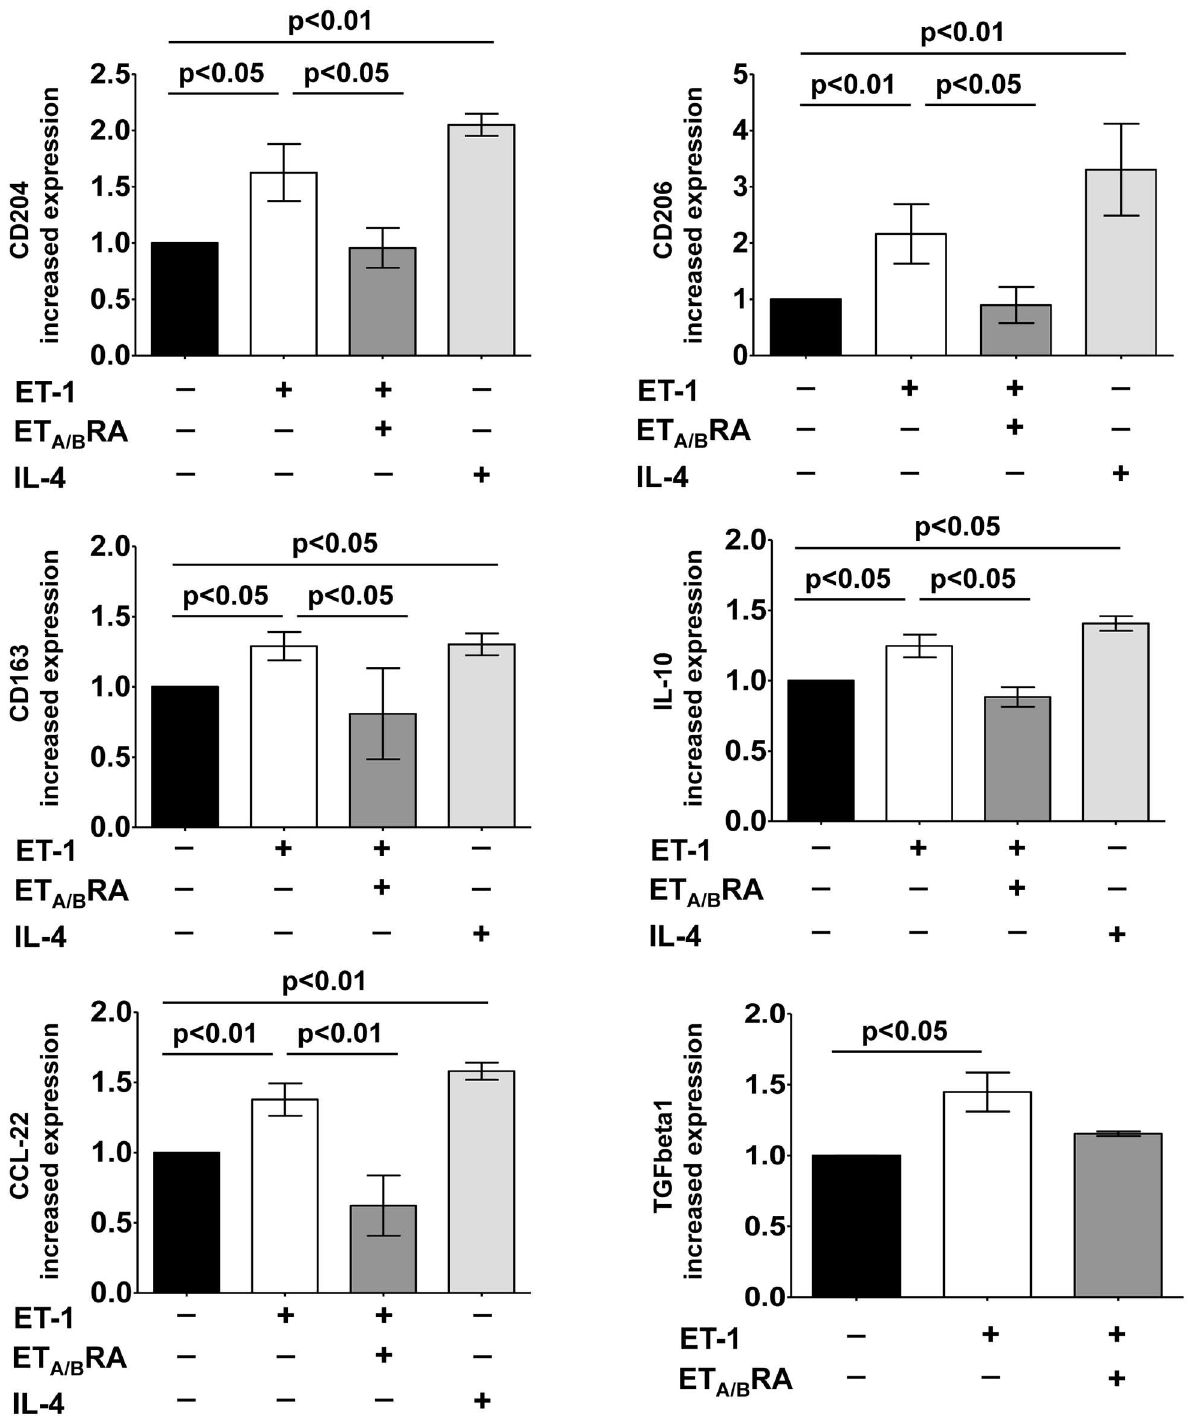
Fig 6. Evaluation of gene expression of M2 macrophage phenotype markers and TGFbeta1 in cultured human monocyte- derived macrophages. Quantitative real time polymerase chain reaction (qRT-PCR) of CD204, CD206, CD163, IL-10, CCL-22and TGFbeta1 gene expressionin cultured humanmonocyte-derived macrophages treated for 6 days with ET-1 (100nM) and IL-4 (10ng/mL) alone, or pre-treatedwith ET A/B RA (bosentan, 10 -5 M) for 1 hour before being stimulatedwith ET-1. Cultured humanmonocyte-derived macrophages maintained for 6 days in RPMI at 10% of FBS were used as untreatedcells. The qRT-PCR was performed on six independent in vitro experiments and the data of CD204, CD206, CD163, IL-10, CCL-22and TGFbeta1 gene expressionare shown as mean ± SDand indicatedas increase in gene